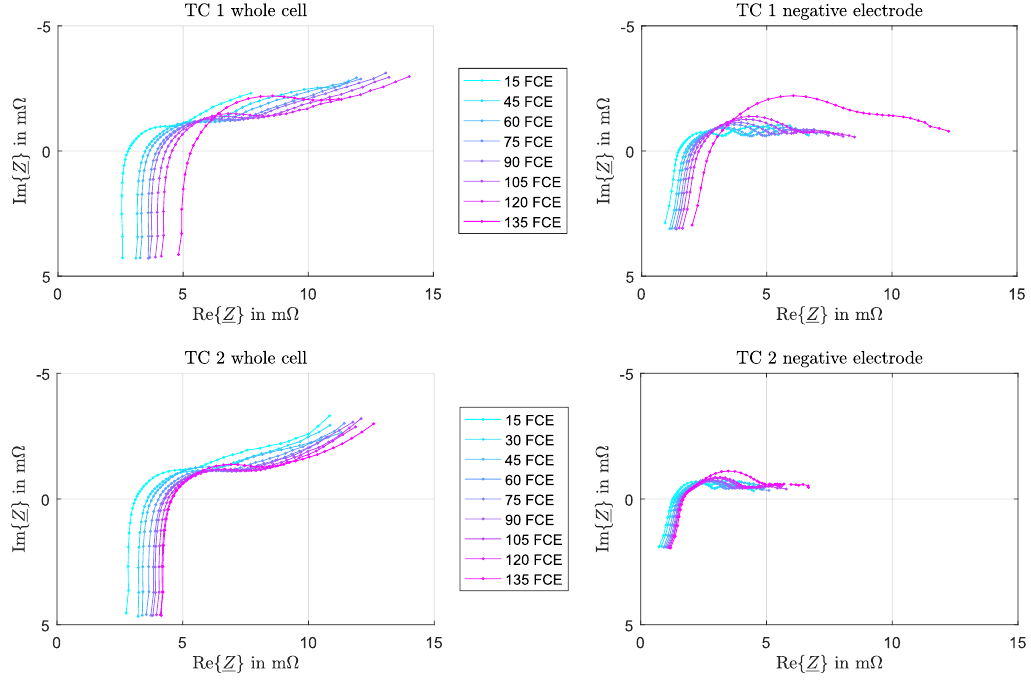
Figure 9. Impedance spectra measured on TC 1 and TC 2 of hard AK3.4 with − 1I 20 after 15–135FCE after the cycling phase. The spectra of the whole cell and the negative electrode are presented. The impedance spectra of the negative electrode are measured using the reference electrode. Impedance values, which do not fulfill TI criterion, have been